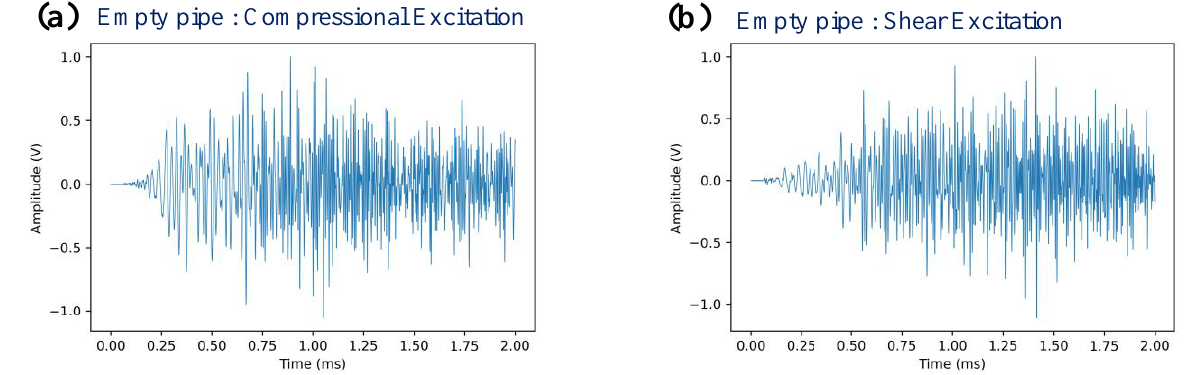
E m p t y p i p e : C o m p r e ss i on a l E x c it a ti on ( a )